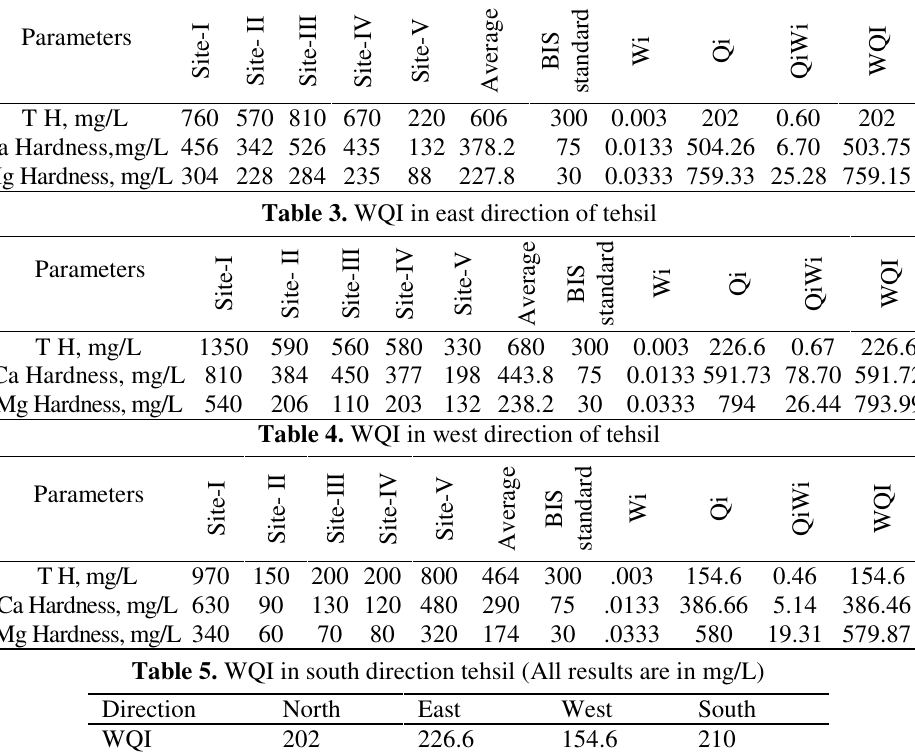
Table 2. WQI in north direction of tehsil